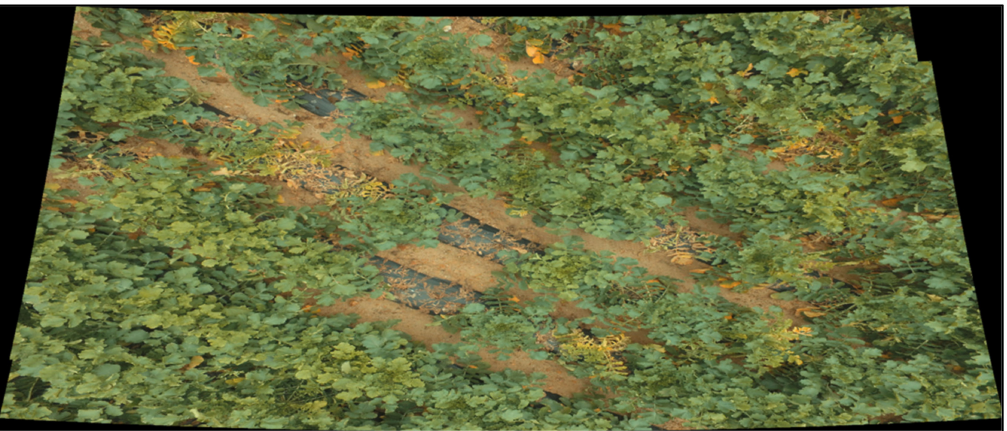
Figure 5. The stitching result for 13 RGB images at an altitude of 3 meters (the mosaic image size is 8404 ×